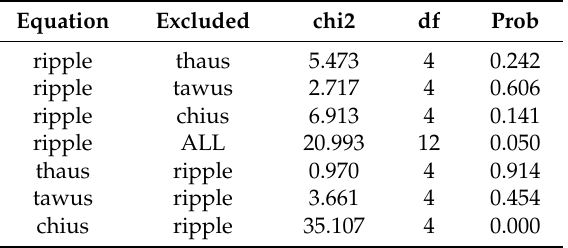
Table 8. Granger causality test for Ripple vs. relevant fiat